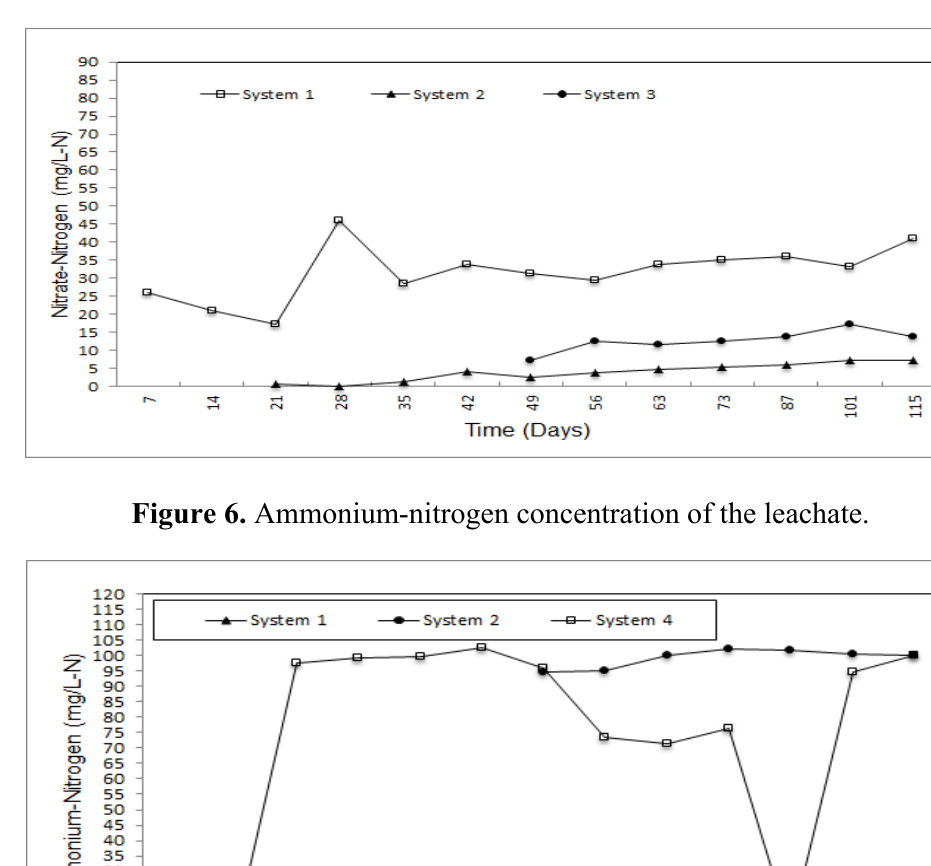
Figure 5. Nitrate-nitrogen concentration of the leachate.